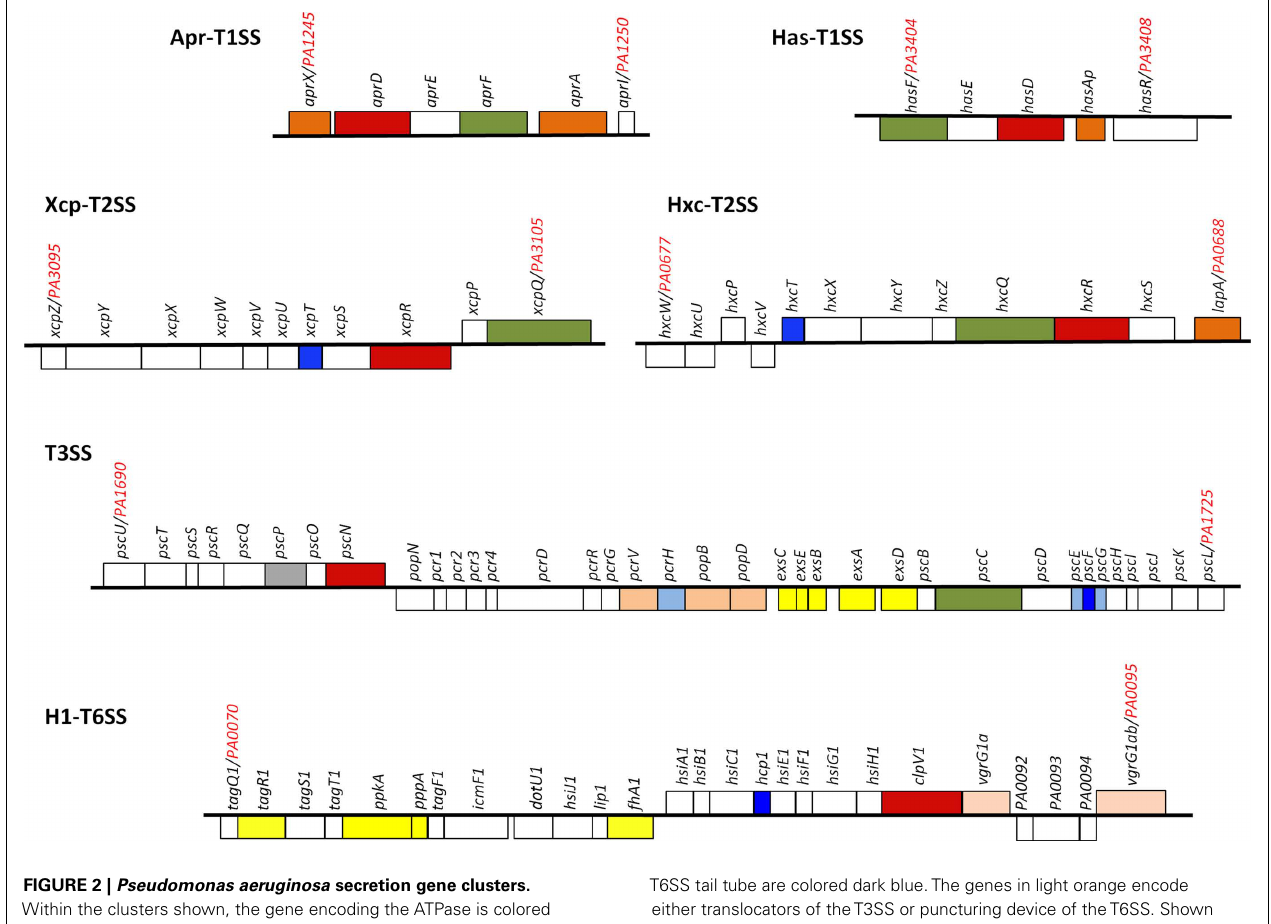
T6SS tail tube are colored dark blue.The genes in light orange encode either translocators of theT3SS or puncturing device of theT6SS. Shown in light blue areT3SS chaperones and in gray theT3SS ruler. Shown in yellow are genes encoding proteins involved in regulation. For more details see